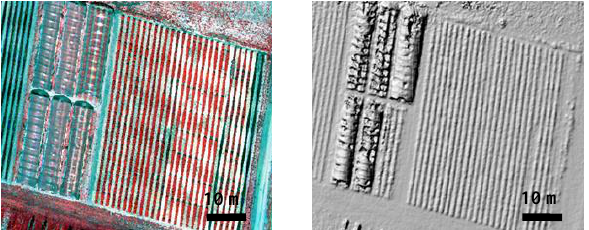
Figure 4. (Left) An overview of the experimental strawberry field at PcFruit, St Truiden, Belgium, shown as false color composite from the COSI hypercube (R=801.7 nm, G=672.6 nm, B=604.0 nm). (Right) Digital Surface Model of the region of interest.